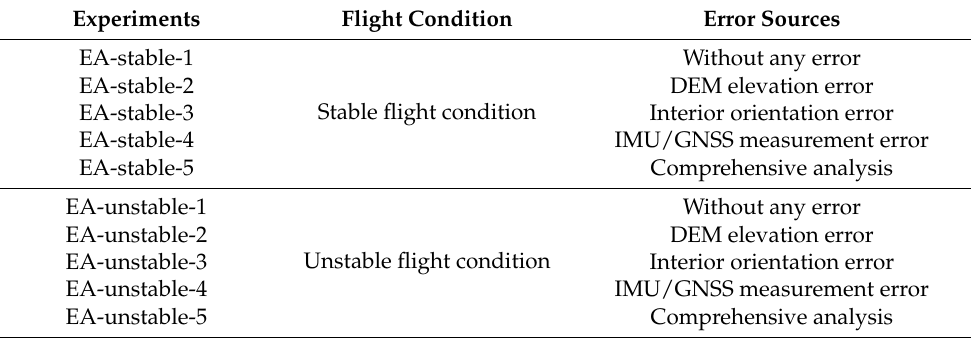
Table 3. Experiments for error sources